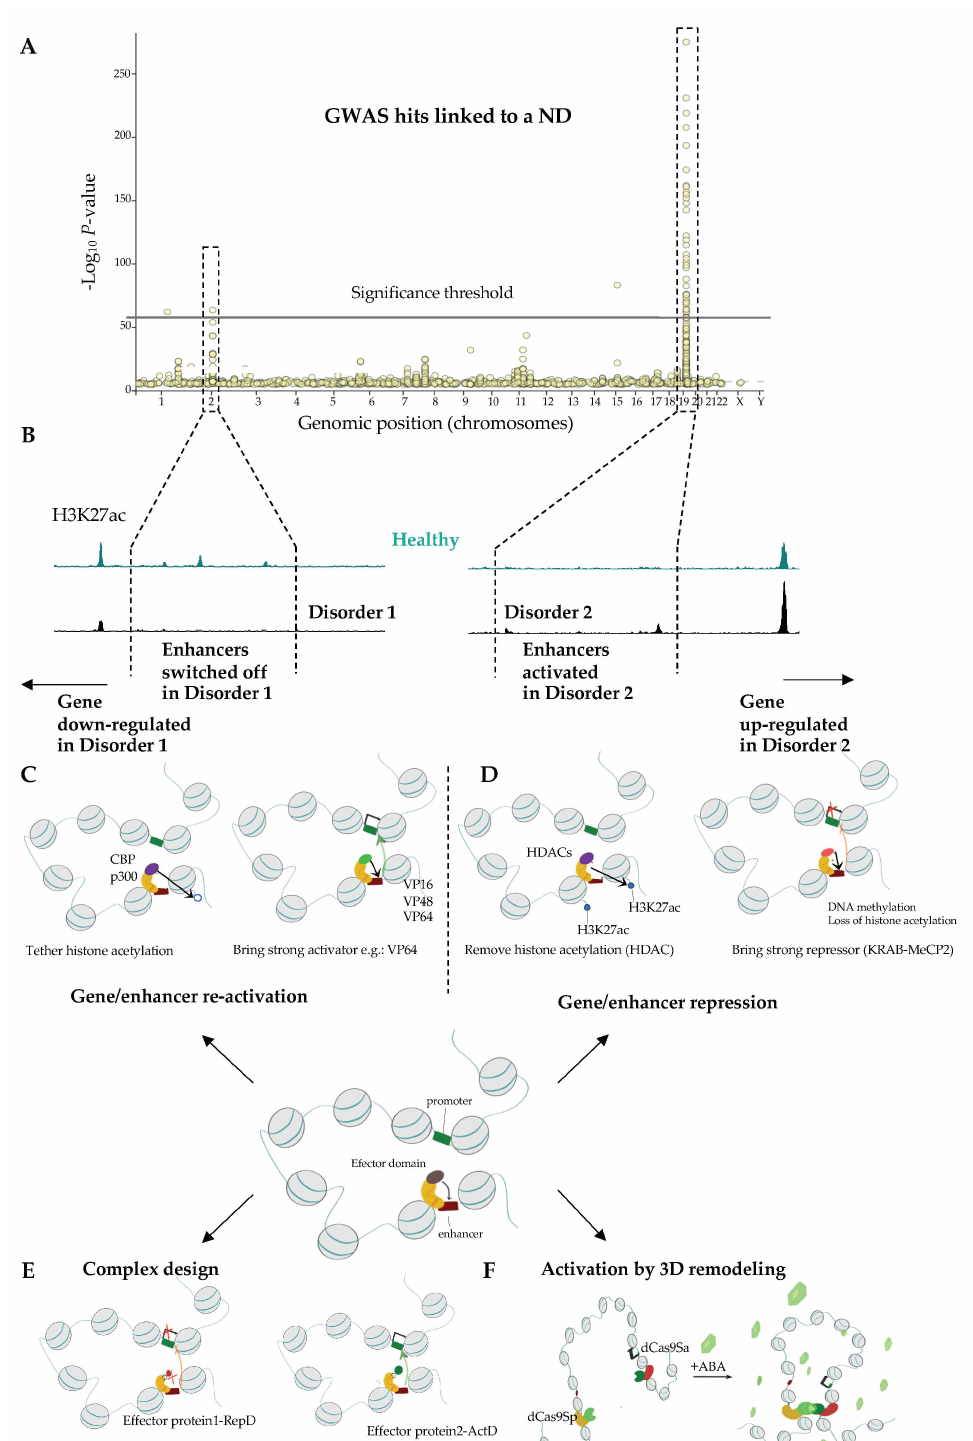
Figure 4. Possible approaches to modulate the activity of the non-coding sequences affected in NDs, including regulatory elements identified in genome-wide association studies (GWAS). ( A ) Manhattan plot displaying an example of GWAS hits linked to a ND. ( B ) GWAS hits may intersect enhancers that can be aberrantly repressed ( left panel) or activated ( right panel) in NDs. ( C ) (Epi)genome editing strategies to activate an aberrantly silenced enhancer element in ND. ( D ) Like in ( C ) but displayed are strategies to repress an aberrantly activated enhancer. CRISPR-dCas9 system consists of DNA-binding domain (catalytically deficient Cas9 (dCas9)), and an effector domain which either activates (ActD) or represses (RepD) the activity of a regulatory sequence (here an